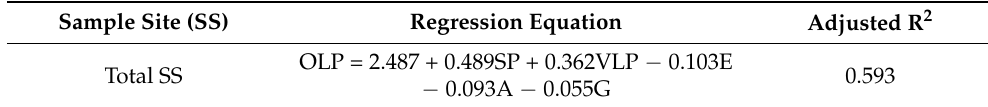
Table 5. Multiple linear backward regression analysis of OLP.